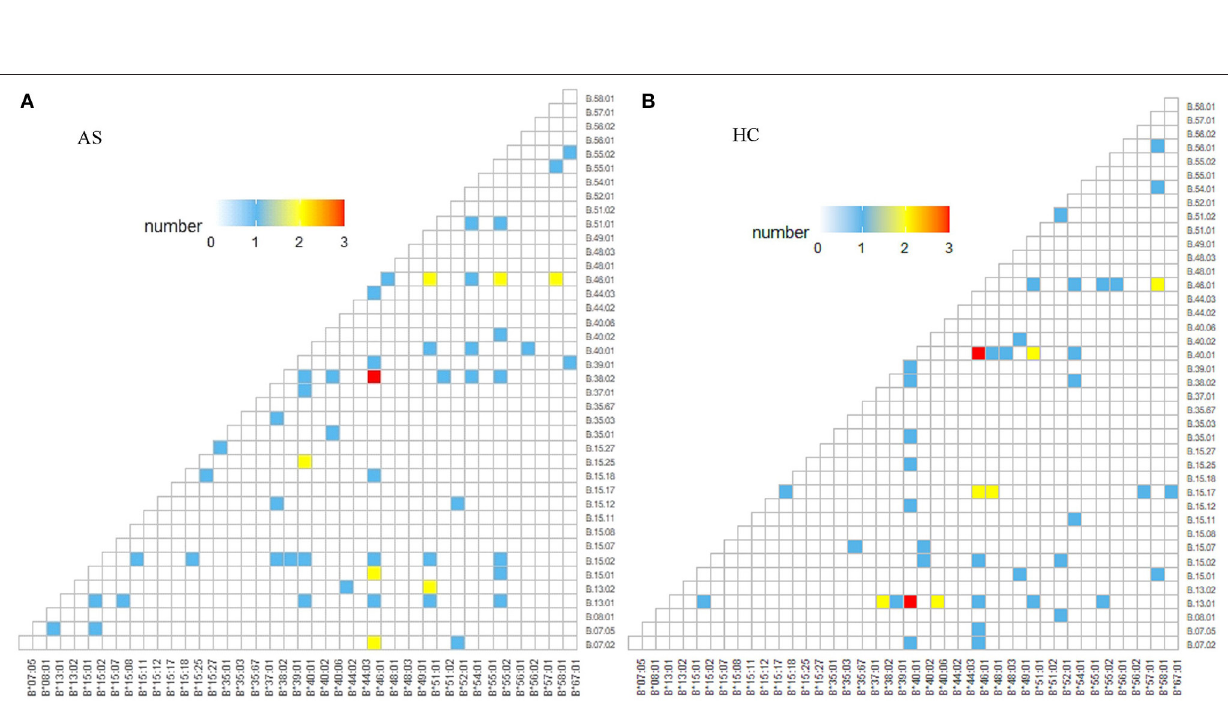
FIGURE 4 | HLA-B alleles heatmap of HLA-B27( − ) group. Each square represents a genotype, like HLA-B*40:01/B*46:01: (A) HLA-B alleles heatmap of HLA-B27( − ) AS patients, and (B) HLA-B alleles heatmap of HLA-B27( − ) controls. AS, ankylosing spondylitis; HC, health